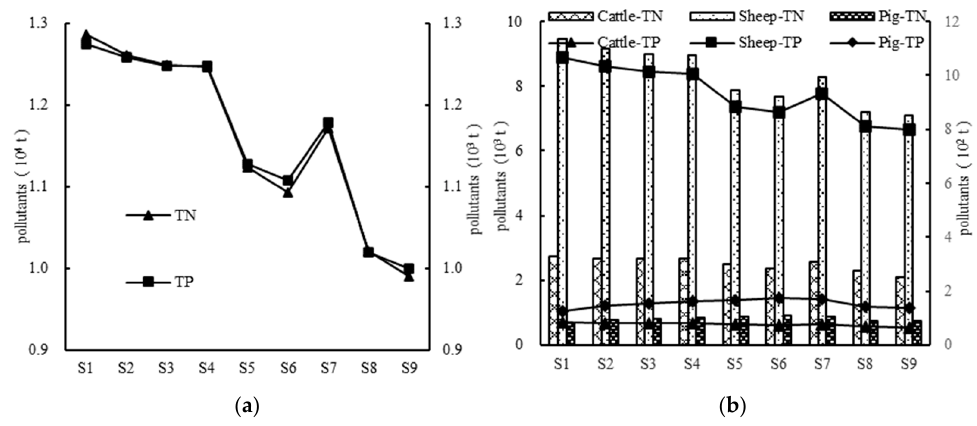
Figure 9. The TN and TP pollution exports of livestock husbandry in Bayan Nur City under nine scenarios. ( a ) Overall livestock husbandry. ( b ) Each livestock.